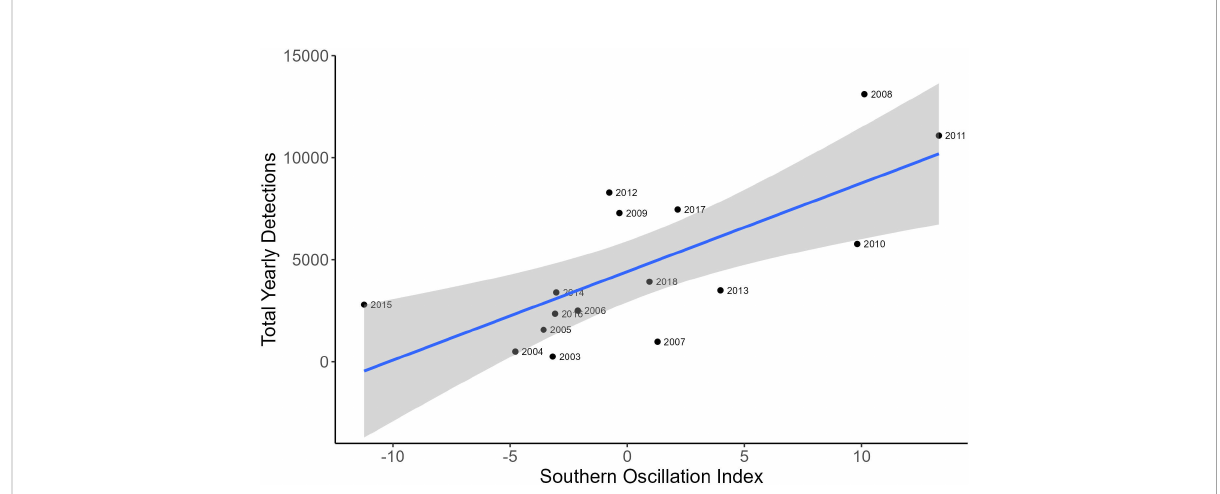
FIGURE 5 A scatterplot showing the correlation between the total yearly EIO pygmy blue whale call detections and yearly average southern oscillation index. The blue line represents line of best fi t and the grey shaded area is estimated 95% con fi dence